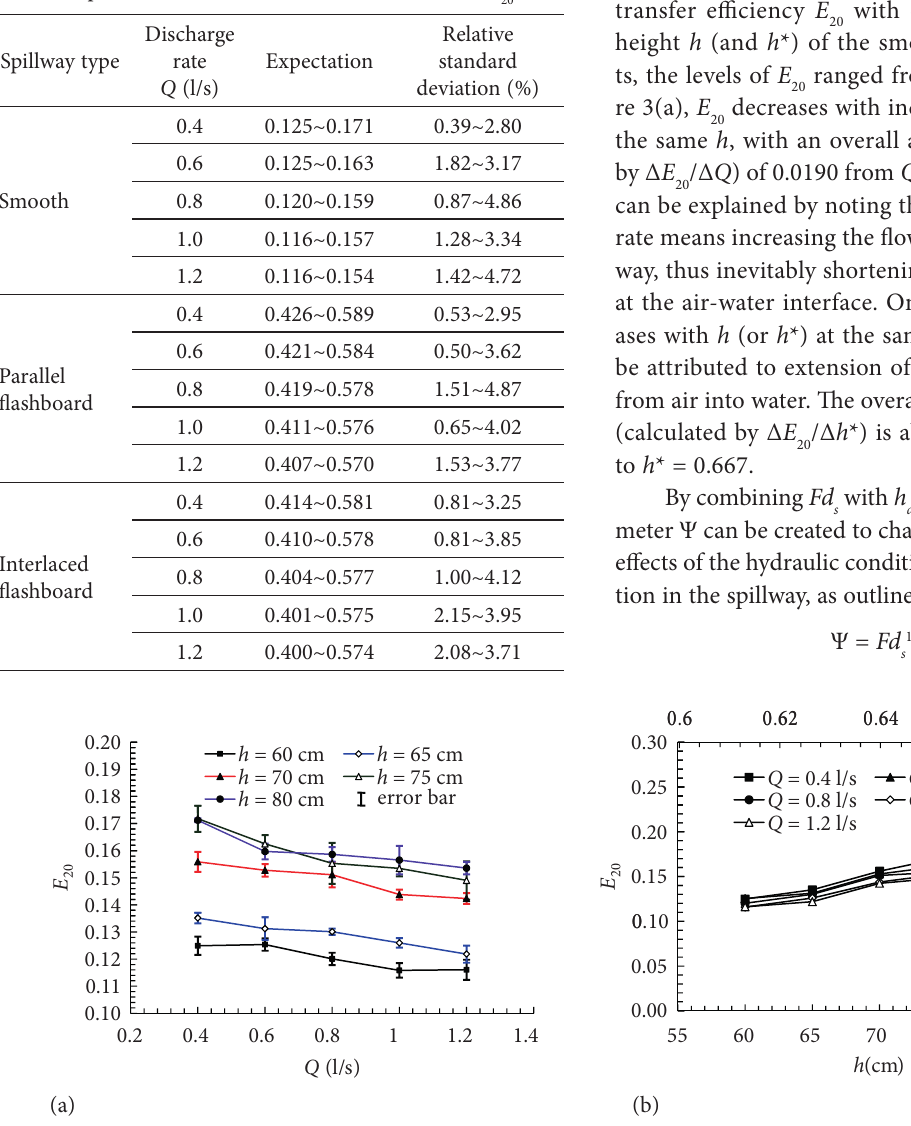
for a smooth spillway: (a) E 20 derived from all measuring data in each 20